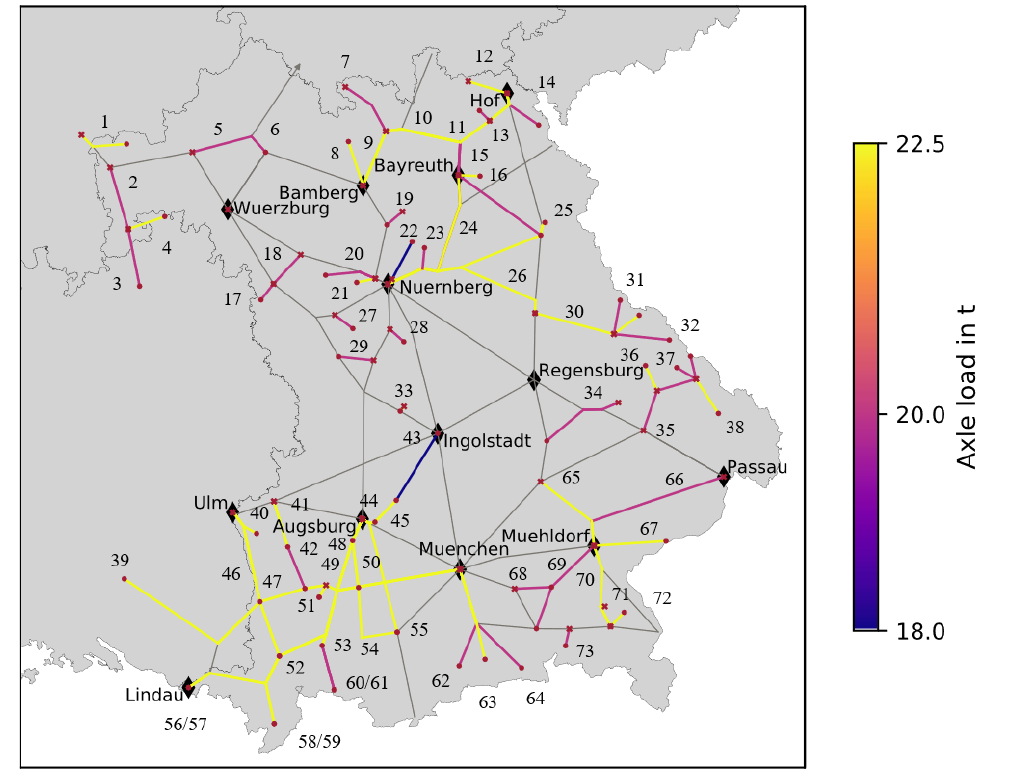
Figure B1: Maximum axle loads on current diesel lines